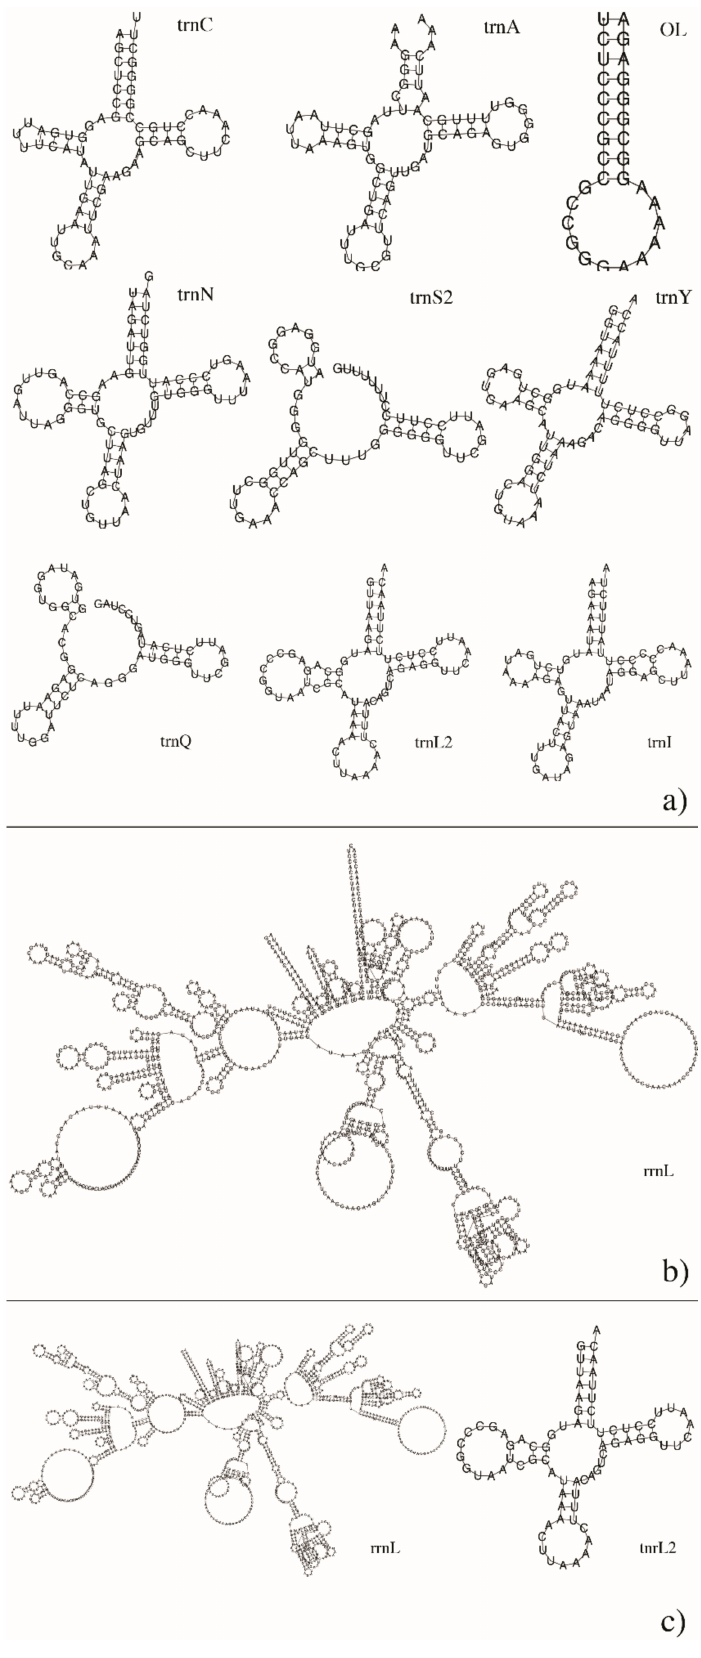
Figure 6. Non-coding RNA secondary structure computed by MITOS2. Figures represent main secondary structures of tRNAs (( a ) and right element of ( c )) and rRNAs (( b ) and left element of ( c )) output by MITOS2 analyses on all RPE cell